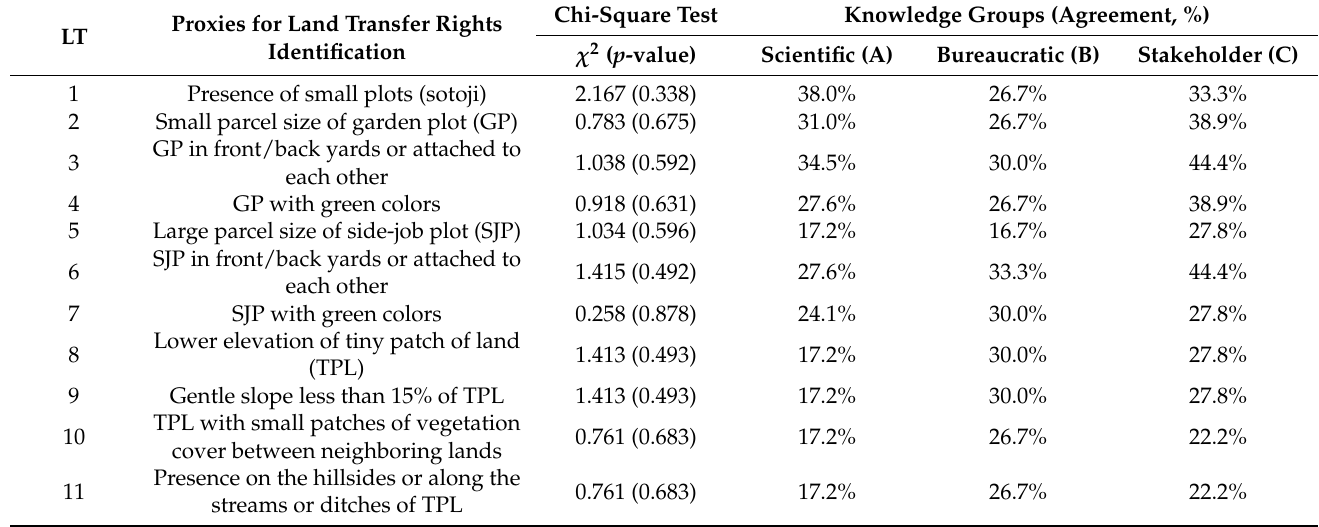
Table 4. Validating the suitability of proxies for land transfer rights identification and differences between knowledge groups.